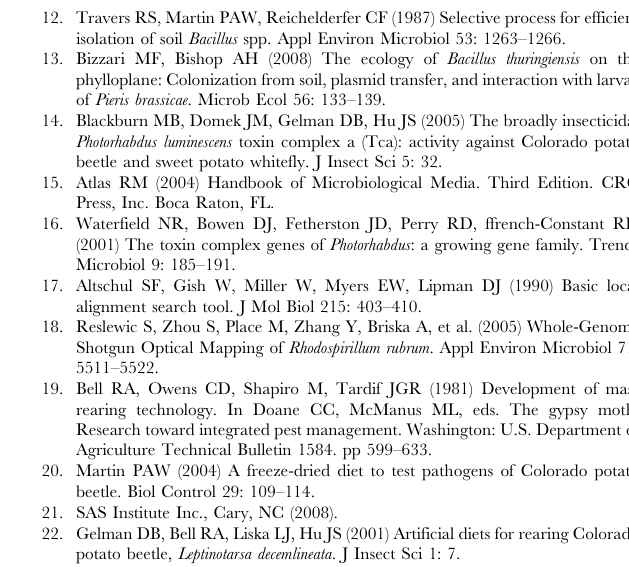
Table S3 Custom TaqMan Assay Bt gene-specific primers and reporter